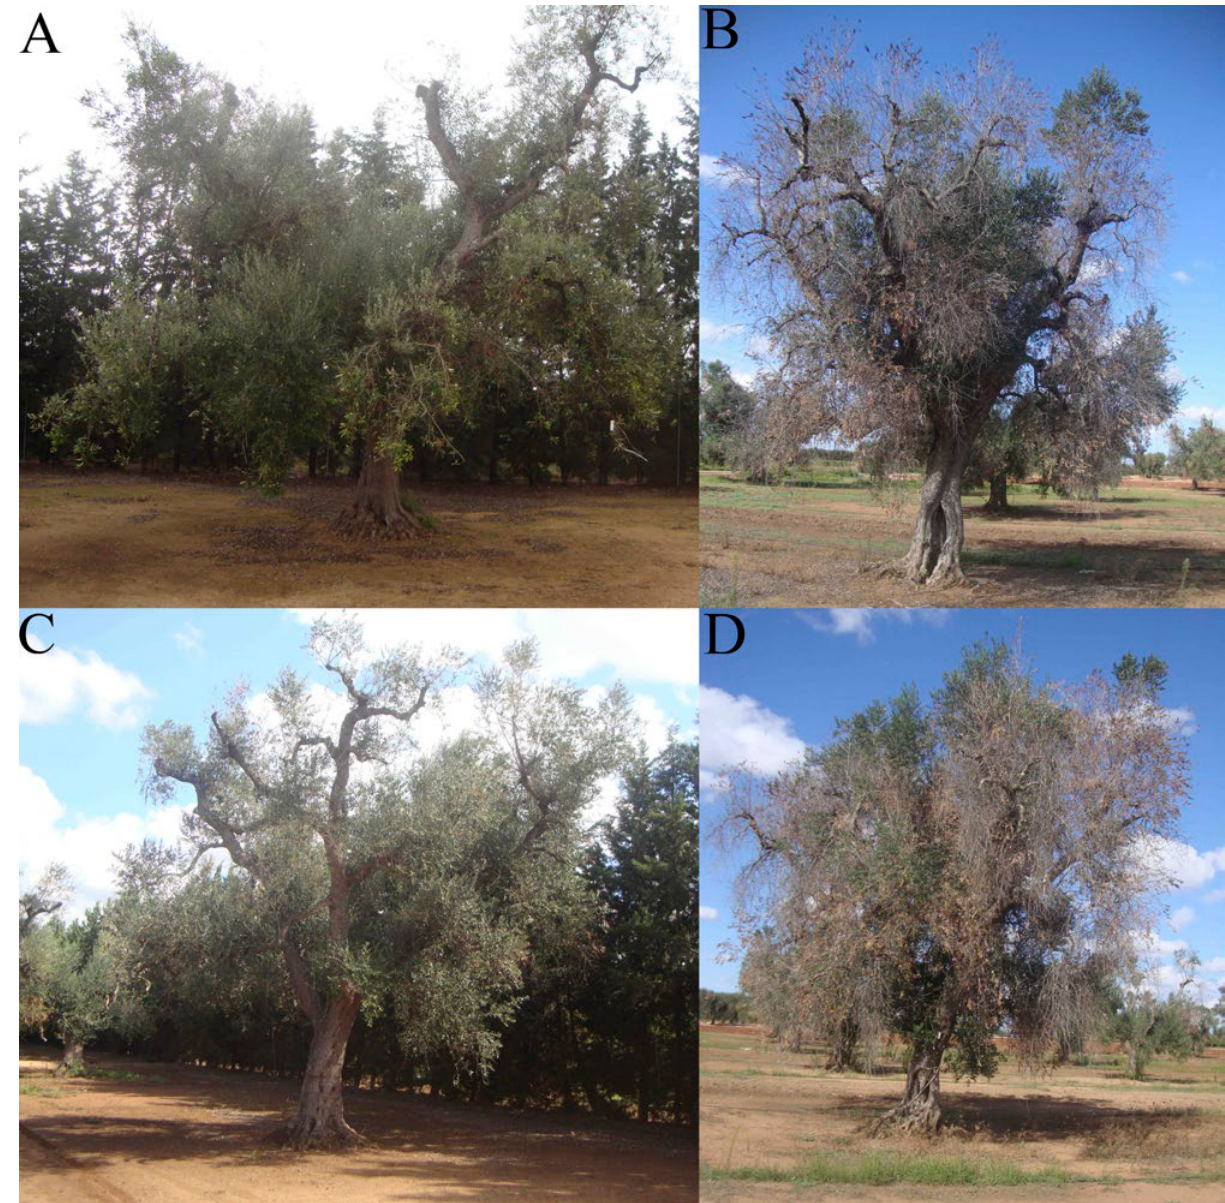
Figure 5. Olive trees photographed at the beginning of October 2017 in Veglie orchard (Lecce province). A: cv. Ogliarola salentina treated with Dentamet®. B: cv. Ogliarola salentina untreated control. C: cv. Cellina di Nardò treated with Den - tamet®. D: cv. Cellina di Nardò untreated control. The treated cv. Ogliarola salentina and cv. Cellina di Nardò trees would have been uprooted on April 2015, according to the prescribed quarantine eradication